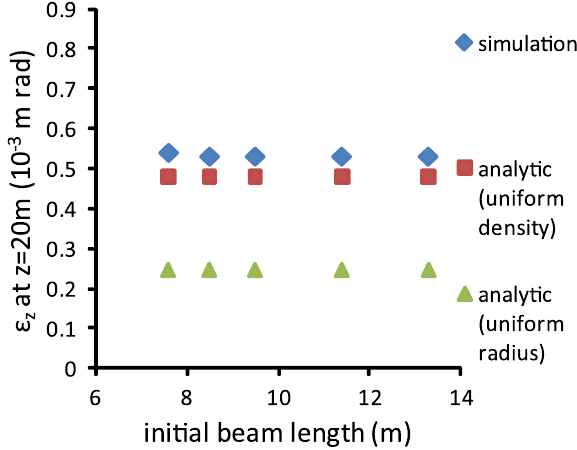
FIG. 18. z emittance at z ¼ 20 m ( (cid:1) 10 (cid:2) 3 ) vs initial beam length with fixed peak current, showing 2 cases with uniform beam radius (green), uniform charge density (red), and WARP simulation (blue).